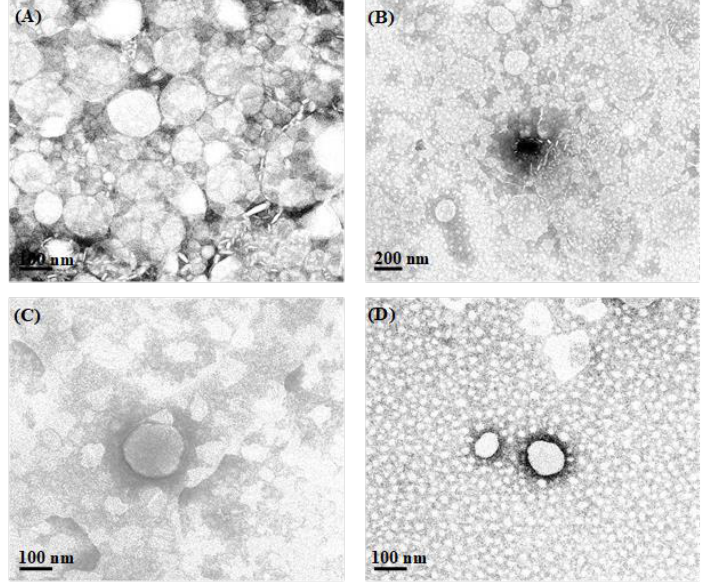
Figure 2. TEM images of lutein-loaded lipid nanocarriers of L-NLC-RBO5 ( A ), L-NLC-RBO10 ( B ), L-NLC-RBO20 ( C ) and L-NLC-VCO20 ( D ). L-NLC-RBO20 ( C ) and L-NLC-VCO20 ( D